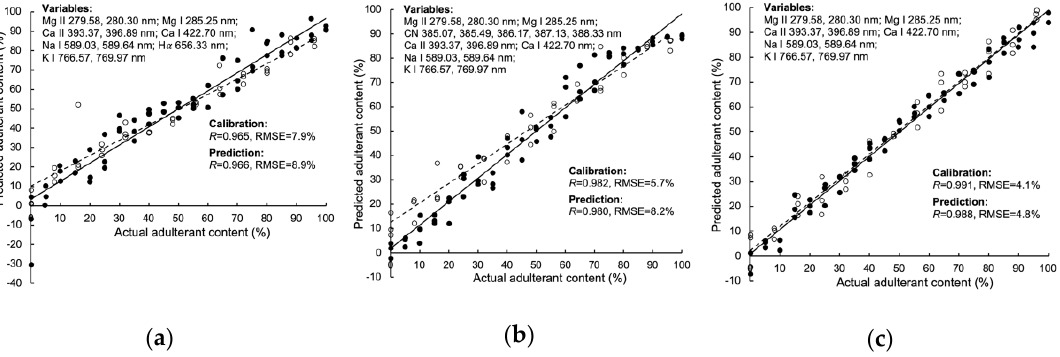
Figure 3. Scatter plot of actual adulterant content vs. LIBS measured adulterant content. Quantification of adulterant content in the mixture of ( a ) acacia honey and HFCS F55 based on the SR-PLSR model; ( b ) acacia honey and HFCS 90 based on the VIP-PLSR model; ( c ) acacia honey and rape honey based on the VIP-PLSR model.